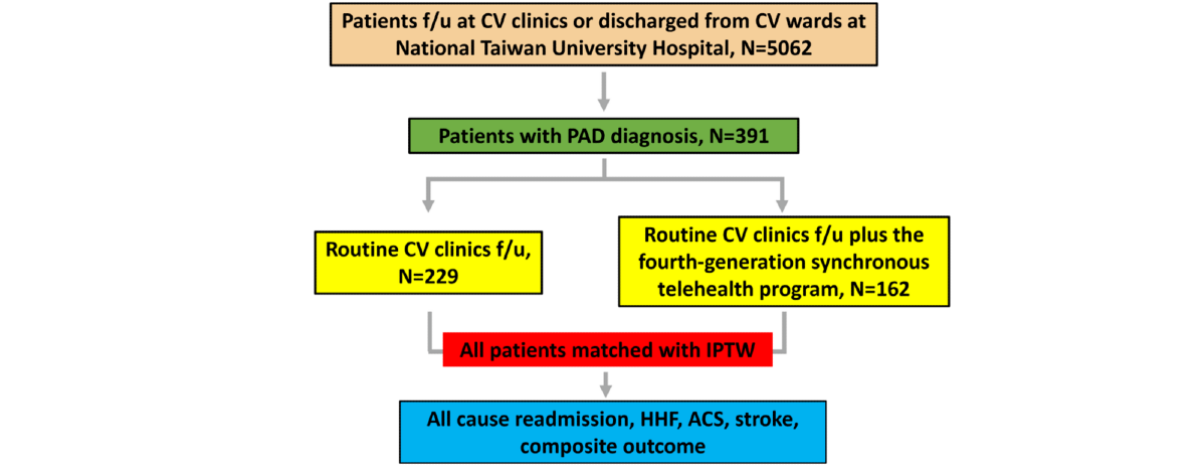
Figure 1. Flow chart of enrolled patients. ACS: acute coronary syndrome; CV: cardiovascular: f/u: follow-up; HHF: hospitalization for heart failure; IPTW: inverse probability of treatment weighting; PAD: peripheral artery